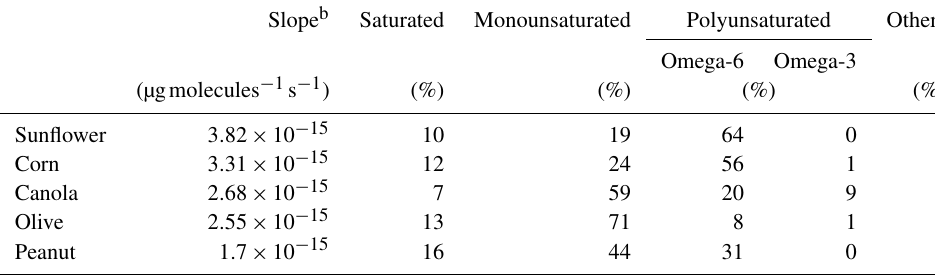
Table 1. SOA production efficiency and type of fat content (%) a of different cooking oils.